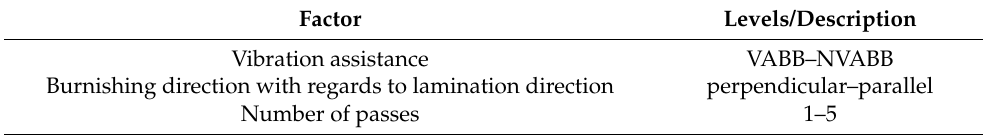
Table 3. Summary of the main testing parameters used during the second experimental phase.